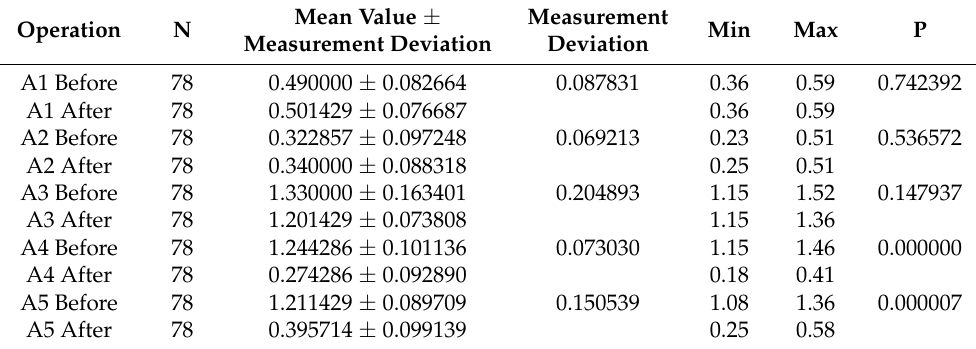
Table 5. Statistical evaluation of measured data